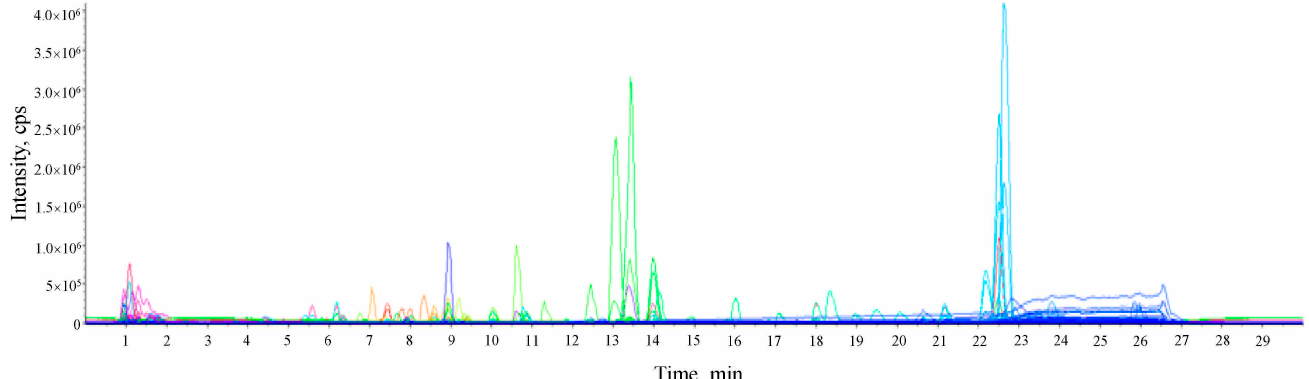
Figure 1. Representative LC-HRMS total ion chromatogram of untargeted metabolome from the ethanolic extract of Lime ( Citrus aurantifolia ) peel. The peaks with high intensity included the purple peak at 8.92 min (hesperidin), the green peak at 13.06 and 13.98 min (5,7-Dimethoxycoumarin and limonin, respectively), and the light blue peaks at 22.51 and 22.6 min (bergaptol and 5-Geranoxy-7- methoxy-coumarin, respectively). Table 1. Identification of chemical components of lime ( Citrus aurantifolia ) peel ethanolic extract using HPLC-qTOF/MS.